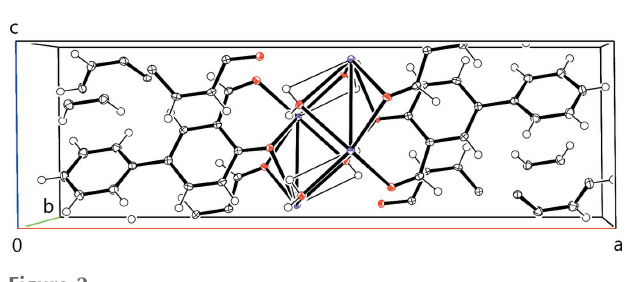
Figure 2 A packing diagram of the title compound.